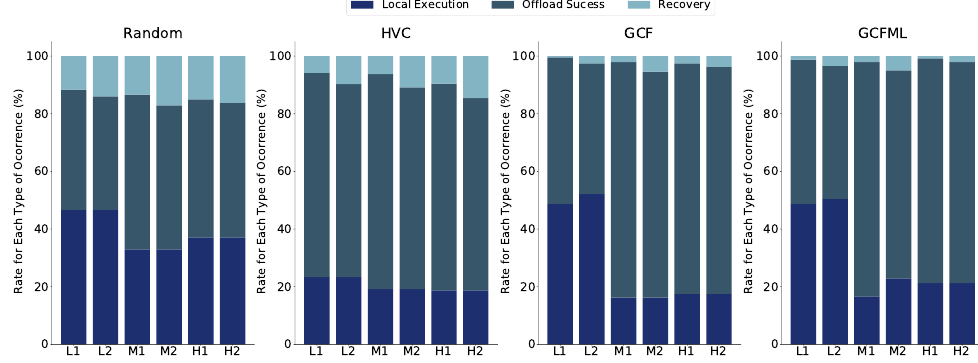
Figure 8. Offloading results in the urban scenario.